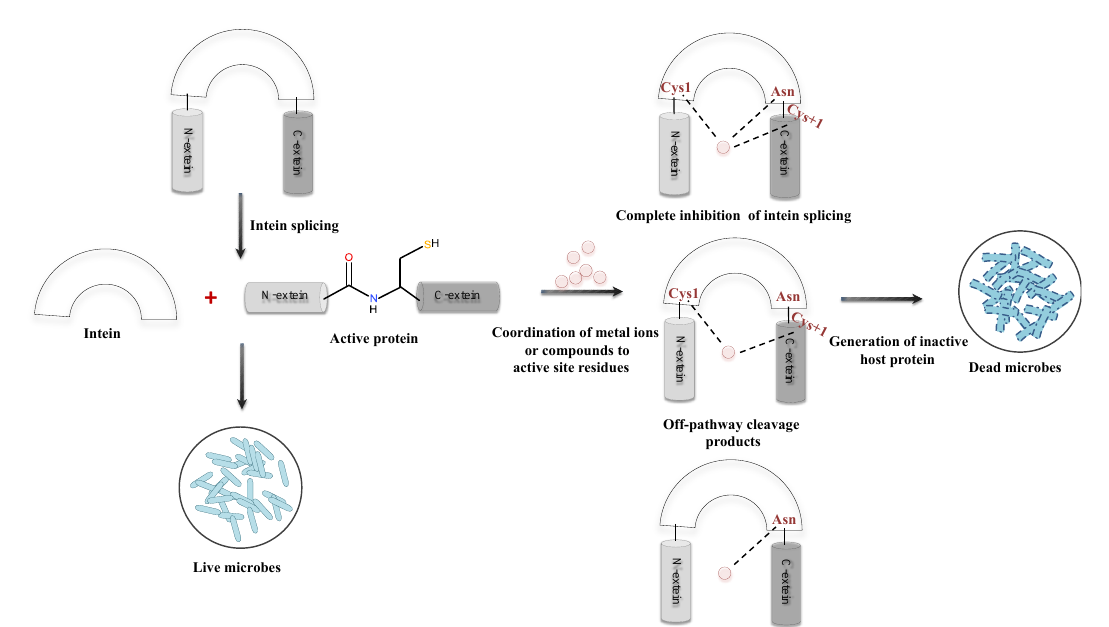
Figure 11. Intein as antimicrobial drug target. Inteins interrupt the functional domains of essential proteins in microorganisms. Removal of inteins generate active proteins, supporting growth and survival of intein-containing microbes. Metal ions or complexes targeting the active site residues can give rise to inactive proteins or off-pathways, splicing byproducts via splicing inhibition, resulting in cell death.